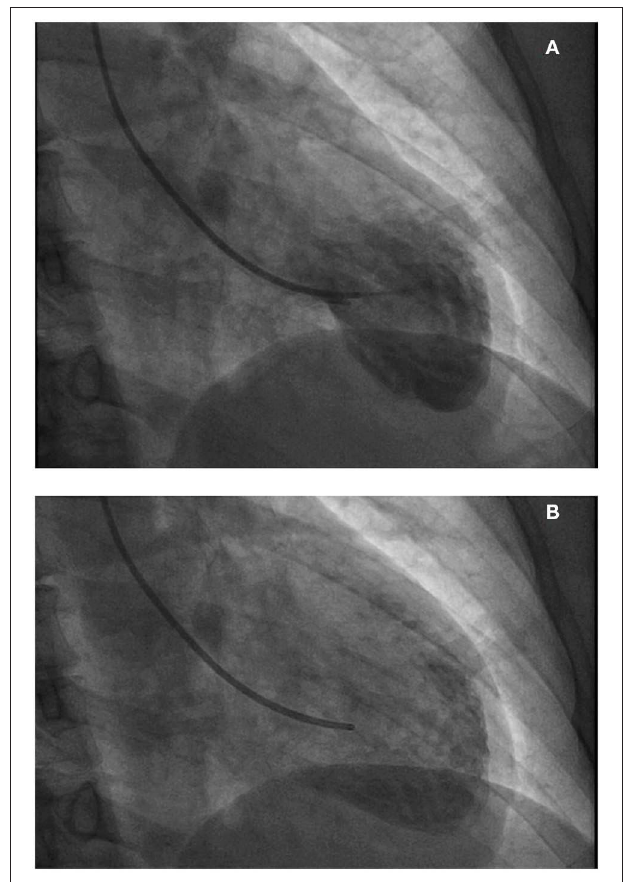
FIGURE 3 | (A,B) Left ventriculography demonstrating apical ballooning and hypokinesis of the apex with normal functioning basal inferior and anterior